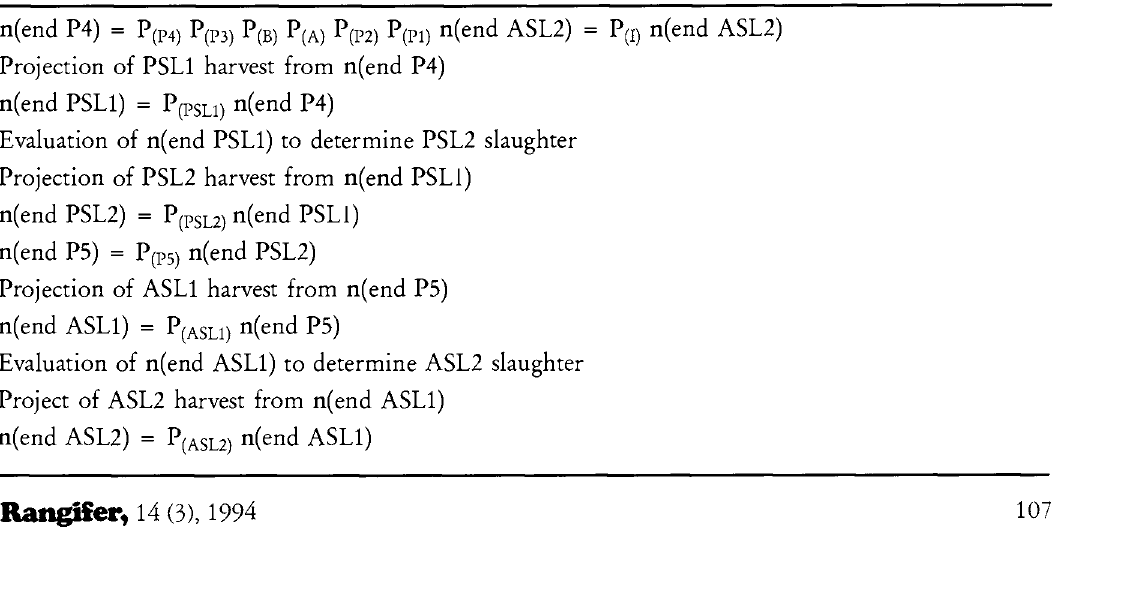
Table 3. A minimum set of computations required to fulfill a yearly cycle including projection of slaughter re venues. Matrix computations are iterations of equation (18] given in the text. Subscripts of P refer to time steps as defined in Fig. 3, is the product of 6 transition probability